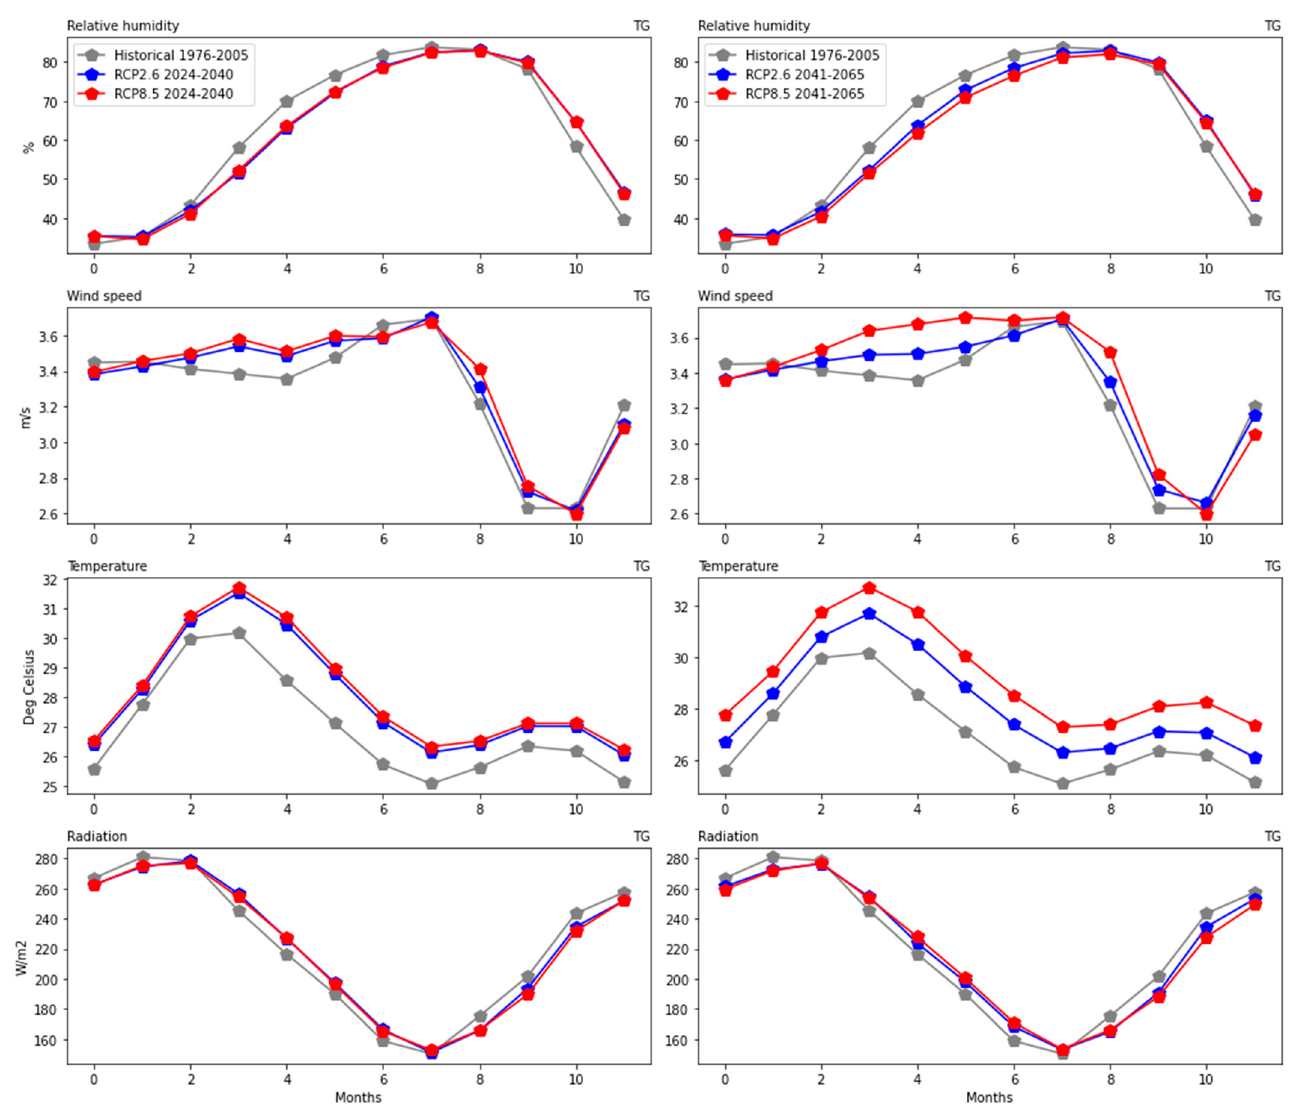
Figure 4. Climatological evolution of Rh, Wspd, Tas and Rs over Togo under RCP2.6 and 8.5 scenarios during 2024–2040 and 2041–2065.